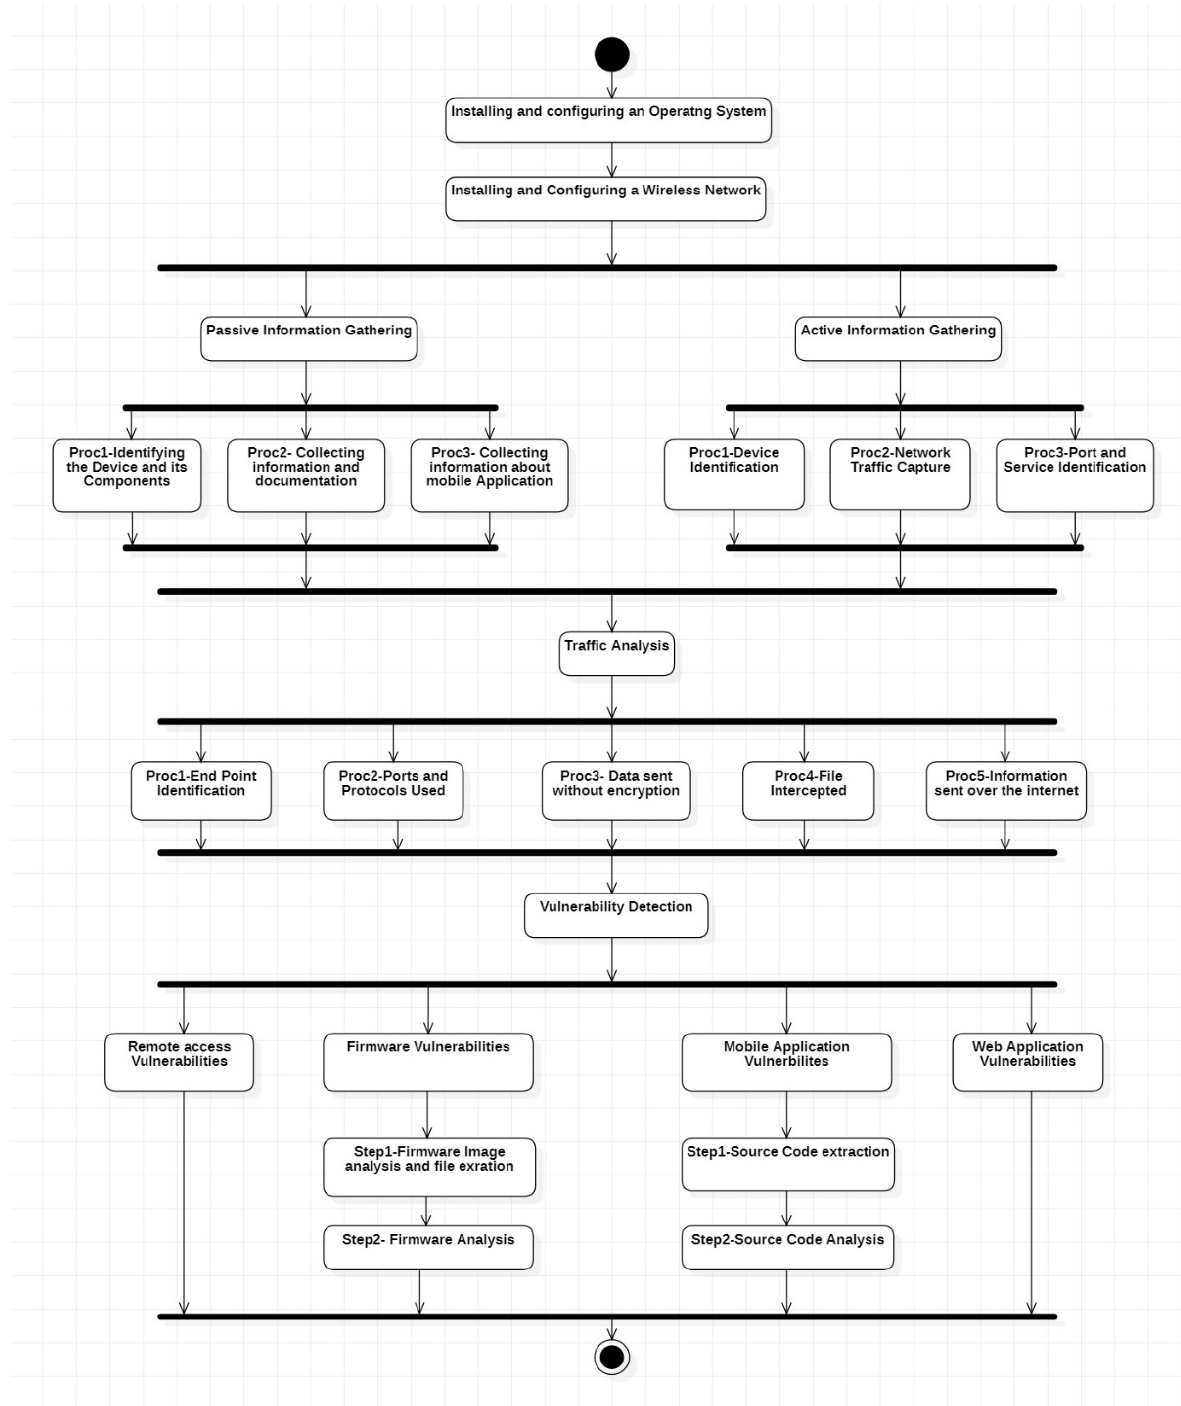
Figure 2. UML activity diagram of the manual penetration testing method. Note: The procedures that are at the same level can be executed in parallel, but one can only proceed to the next level if all the procedures in that level are